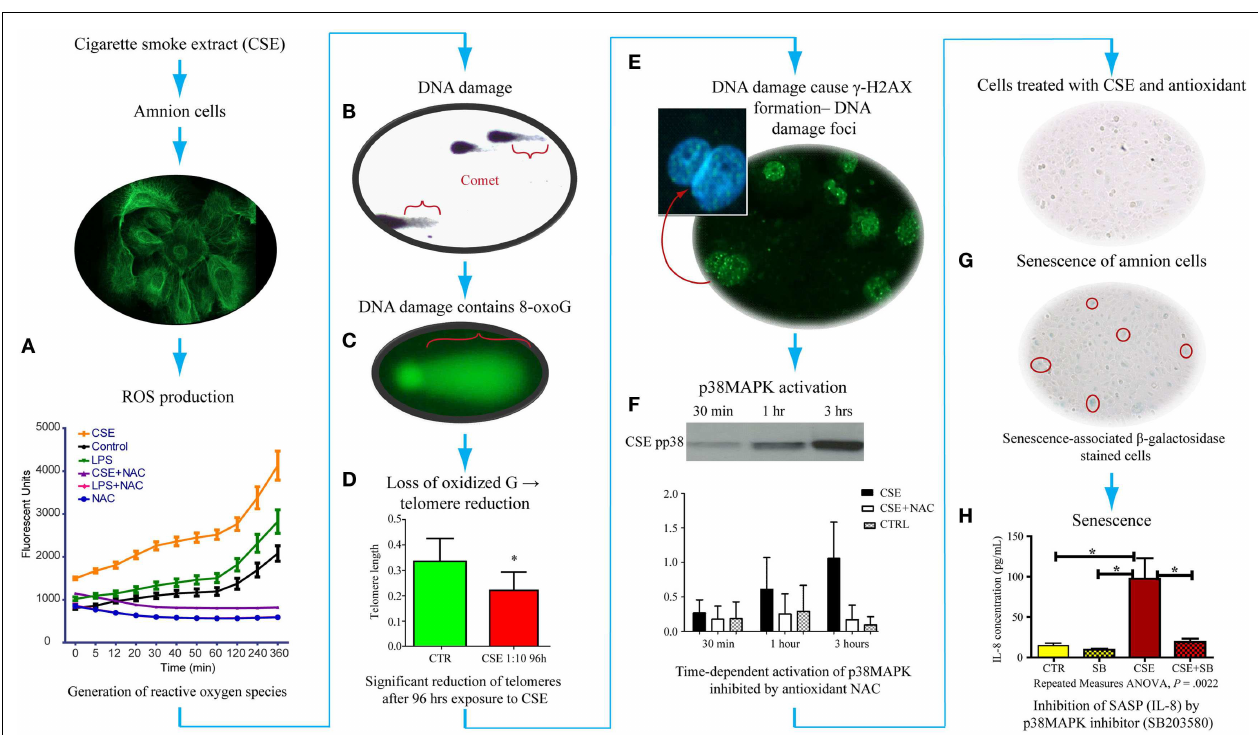
confirmed 8-oxoG production, one of the most lethal biomarkers, in response to CSE, indicating 8-oxoG:OGG1 complex activity. (D) Exposure of these cells to ROS (by CSE) led to reduction of telomere length ( P < 0.05), confirming a similar observation reported in fetal membranes from pPROM. (E)